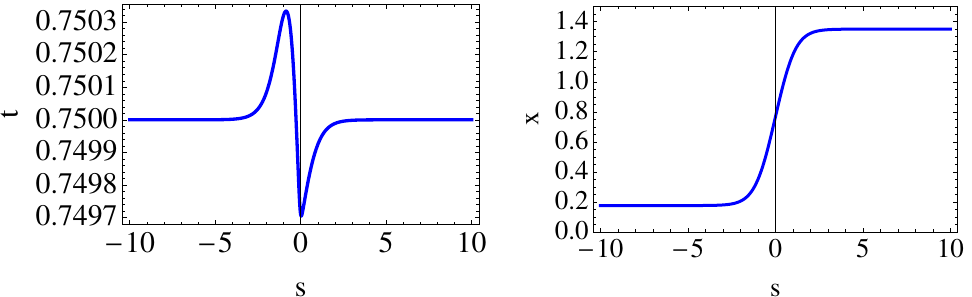
Figure 5 . Parametric dependence of the geodesic as a function of the a(cid:14)ne parameter s . We show t = t ( s ) (left) and x = x ( s ) (right). We have considered the interval x A 2 [0 : 175 ; 1 : 35] as shown in (cid:12)gure 4, and t 0 = 0 : 75, see equation